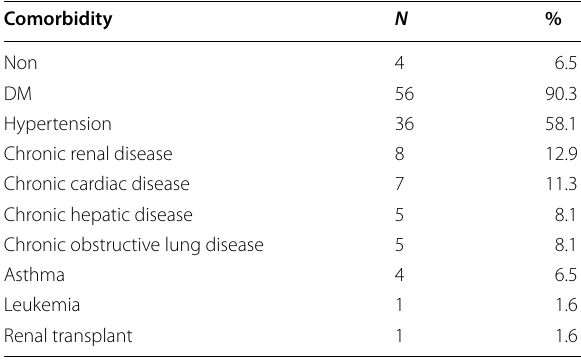
Table 1 Co‑morbidities for the studied